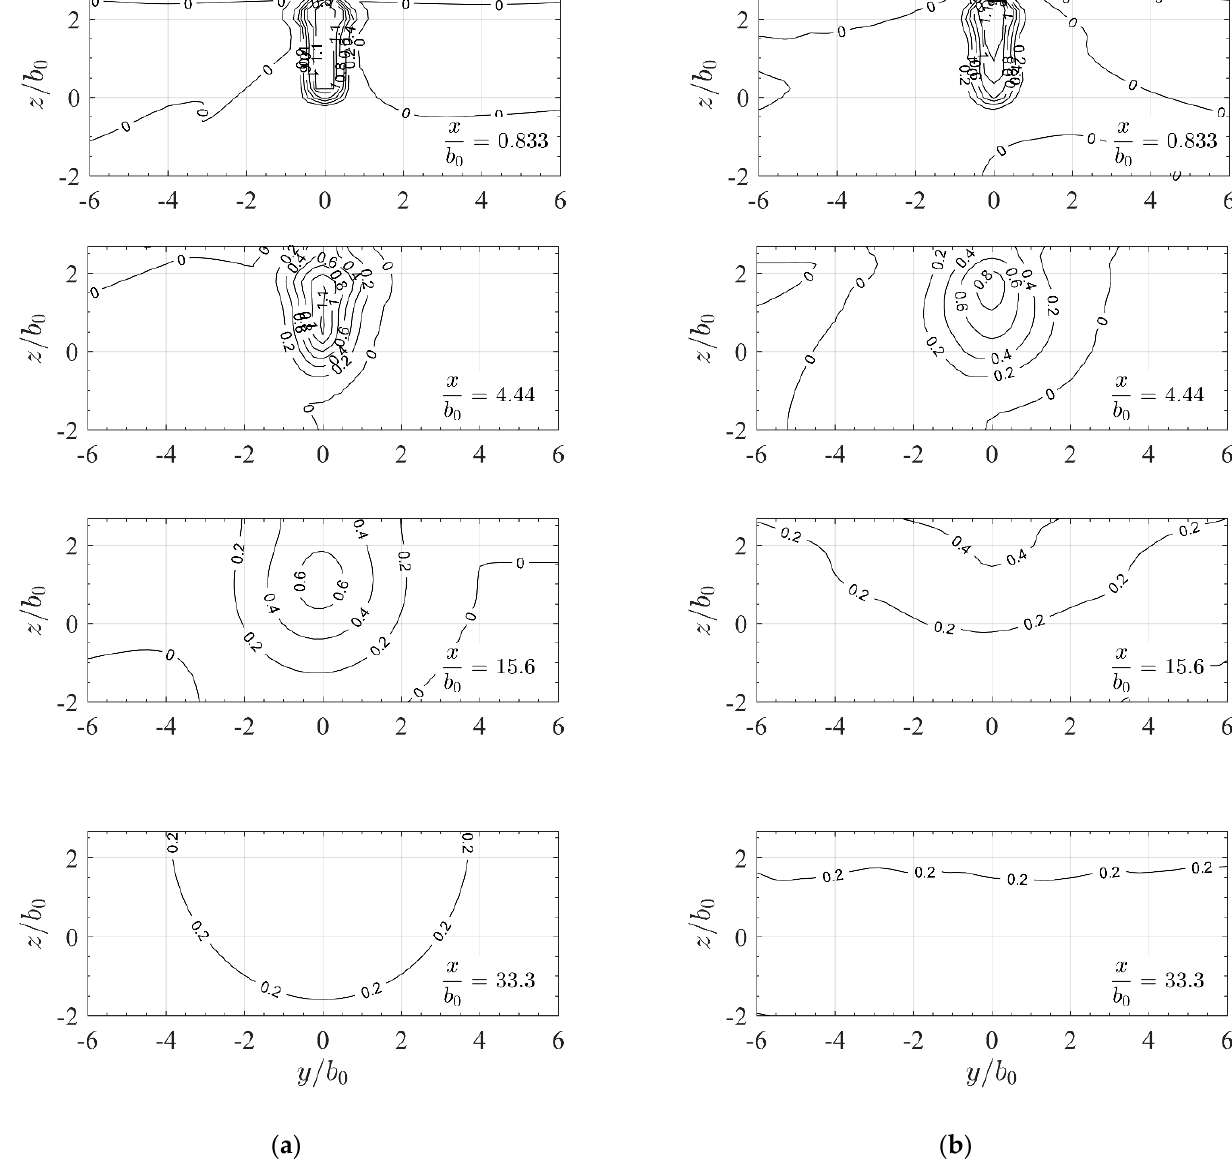
Figure 10. Slot jet with inhomogeneous approach flow showing isolines of the normalized streamwise velocity component u / u 0 in yz-sections with relative distances x / b 0 from the orifice as simulated for ( a ) si-rans and ( b ) si-des slot configurations. Distances y and z are normalized with channel/slot width b 0